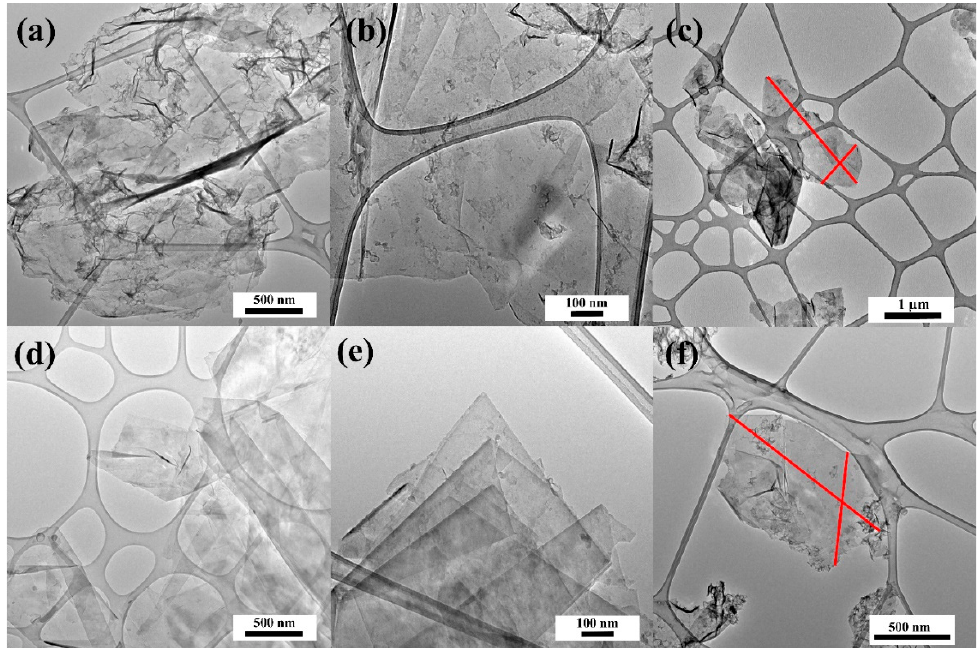
Figure 5. High-resolution transmission electron microscopy (HRTEM) images of (a–c) EG_F_2 and (d–f) EG_F_1. ( d – f )